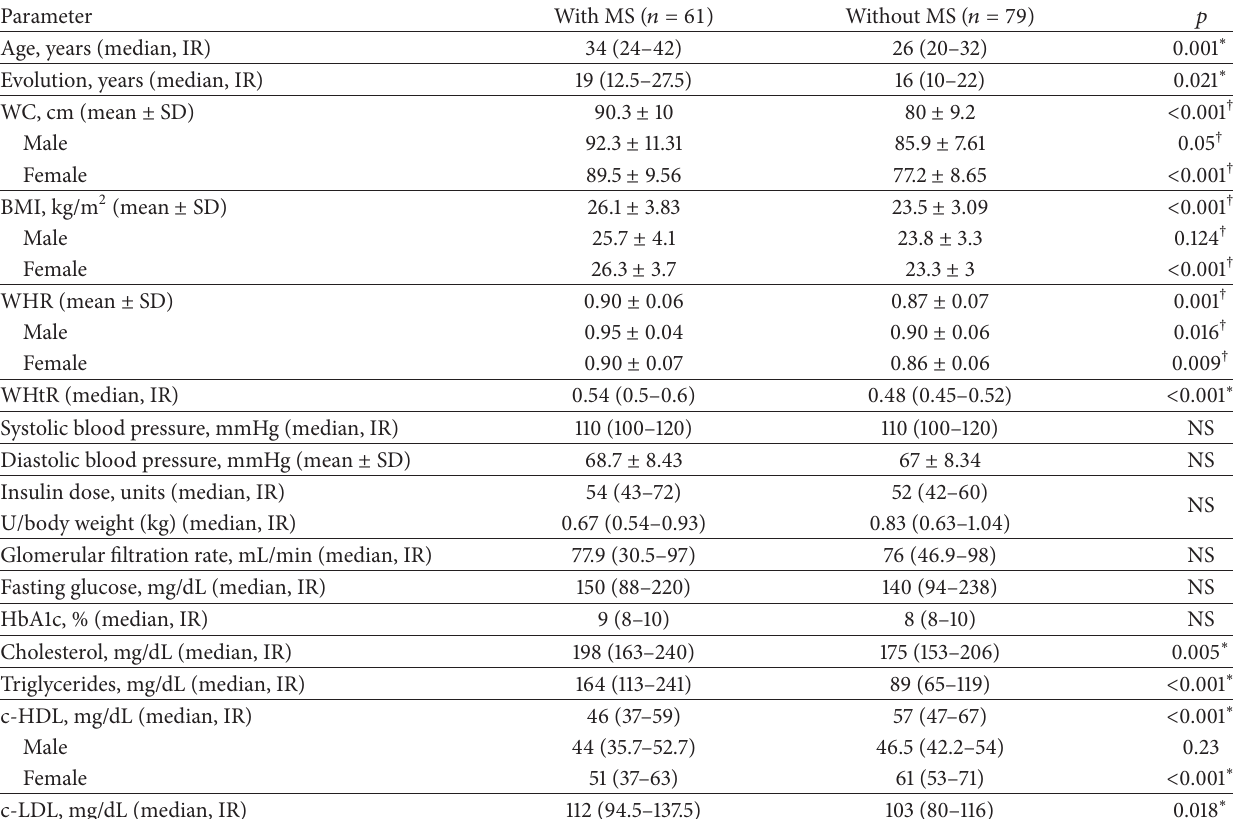
Table 1: Baseline characteristics of the population comparing patients with and without MS.